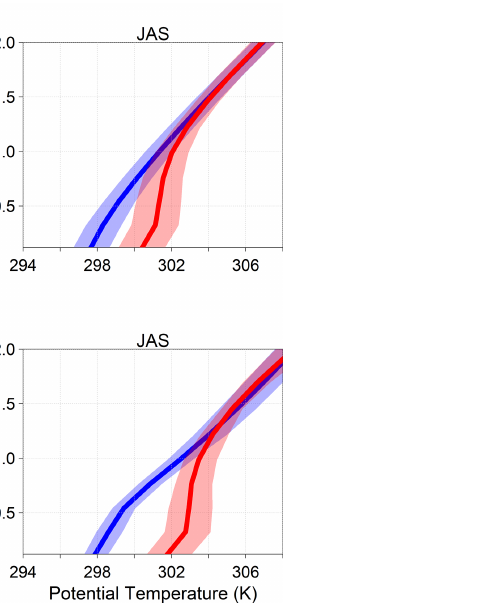
Figure B2. Vertical profile of the mean potential temperature (solid line) for the lowest 2km of the atmosphere, computed in Guinea and the Sahel for all the “1h” preceding LLC Class-2 occurrence and all the “1h” after its disappearance. The shaded regions represent the 10th and 90th inter-percentile range. No event of LLC Class-2 has been extracted in the Sahel area during DJF, hence the empty